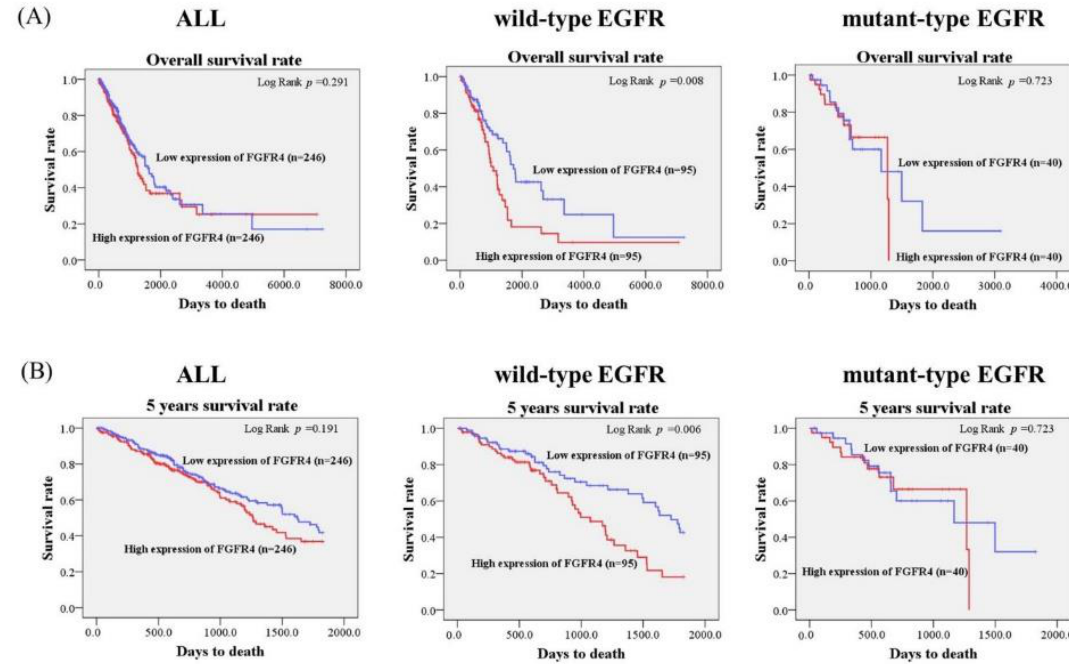
Figure 1. Association of FGFR4 mRNA level and survival rates in lung adenocarcinoma patients from The Cancer Genome Atlas (TCGA) database. ( A ) The e ff ects of FGFR4 mRNA expression on the overall survival of patients with lung adenocarcinoma were evaluated with the Kaplan-Meier plot using the Log-rank test. ( B ) The e ff ects of FGFR4 mRNA expression on the five-year survival of patients with lung adenocarcinoma were evaluated with the Kaplan-Meier plot using the Log-rank test.